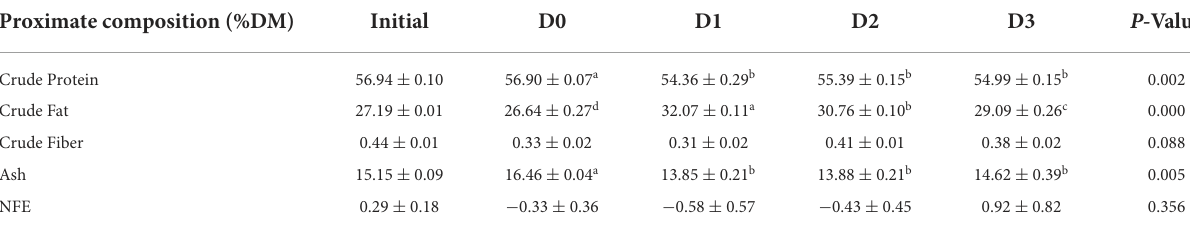
TABLE 5 Proximate composition (%) of seawater-tolerant tilapia fed with diets supplemented with T. weissflogii paste. Proximate composition (%DM)